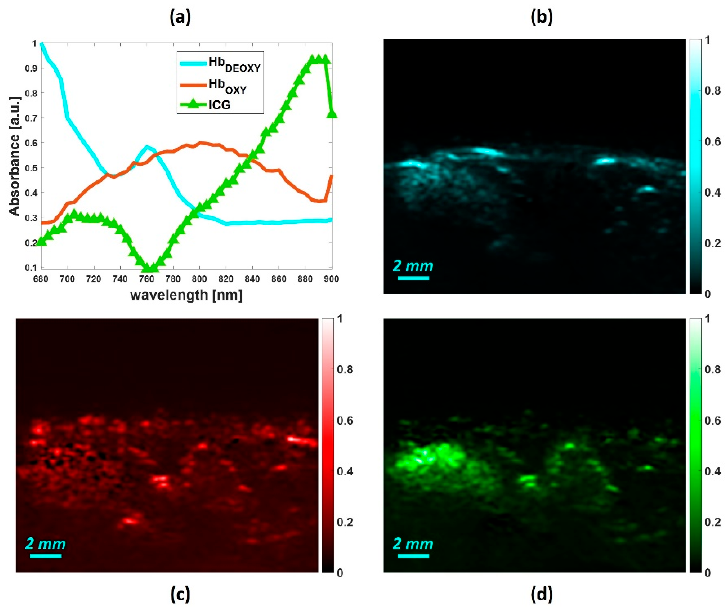
Figure 7. Post-injection conditions: ( a ) spectral signature of the endmembers obtained by using NNMF and abundance distribution maps of ( b ) deoxyhemoglobin, ( c ) oxyhemoglobin, and ( d ) ICG.